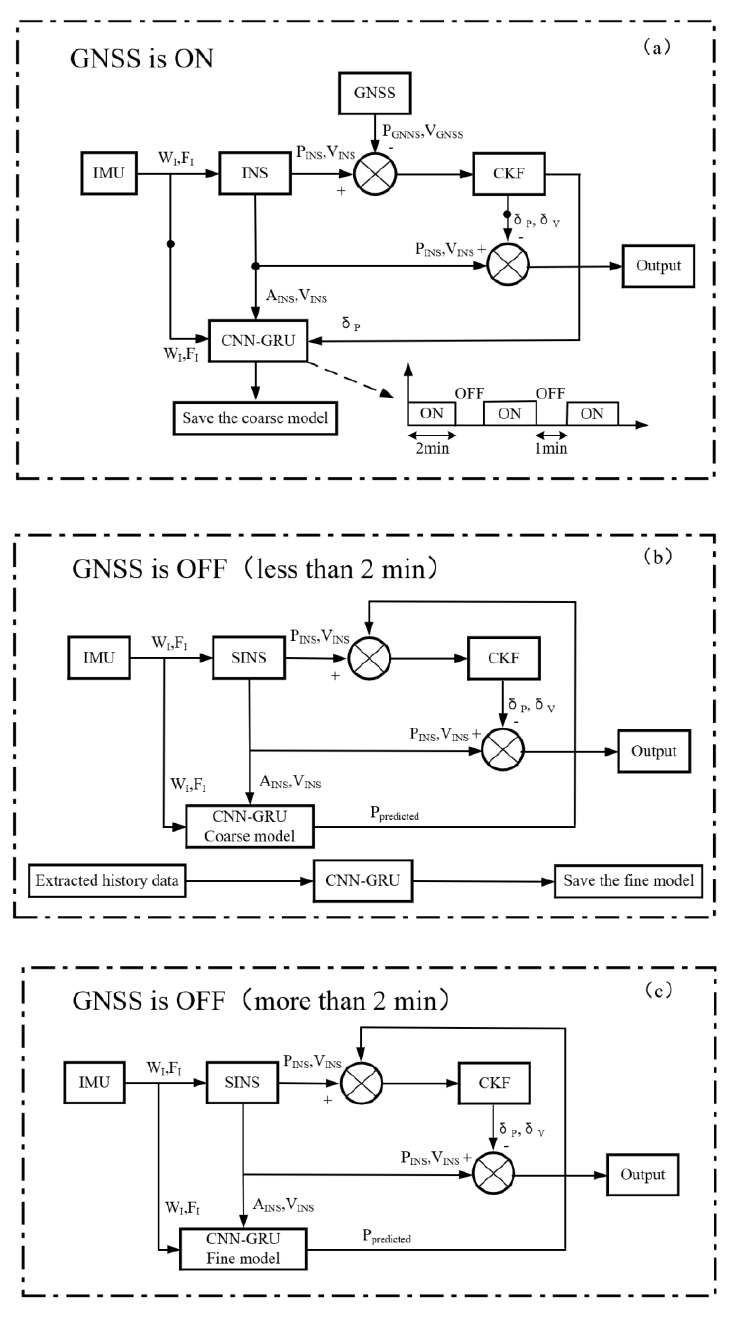
Figure 2. The overall architecture of the proposed method ( a ) GNSS is available; ( b ) GNSS ioutage (less than 2 min); ( c ) GNSS outage (more than 2 min).